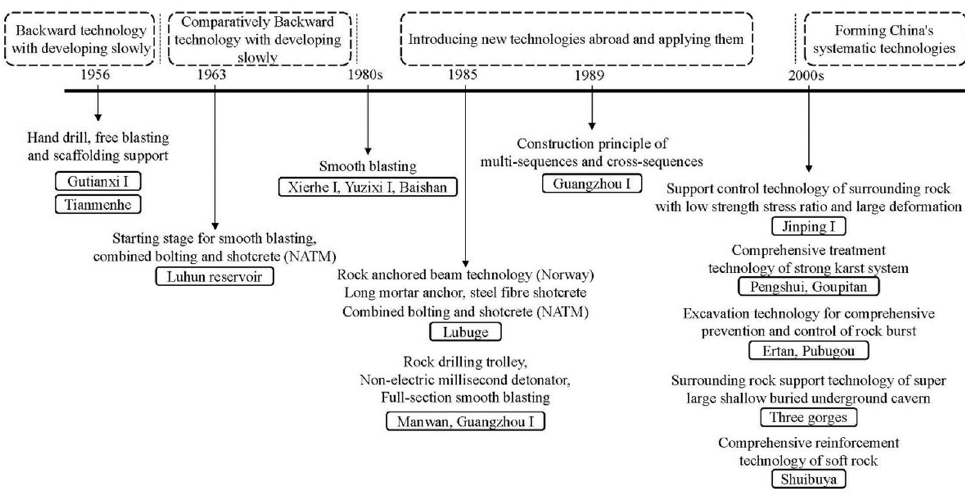
Figure 7. The improvement history of excavation technology for underground powerhouses in China.